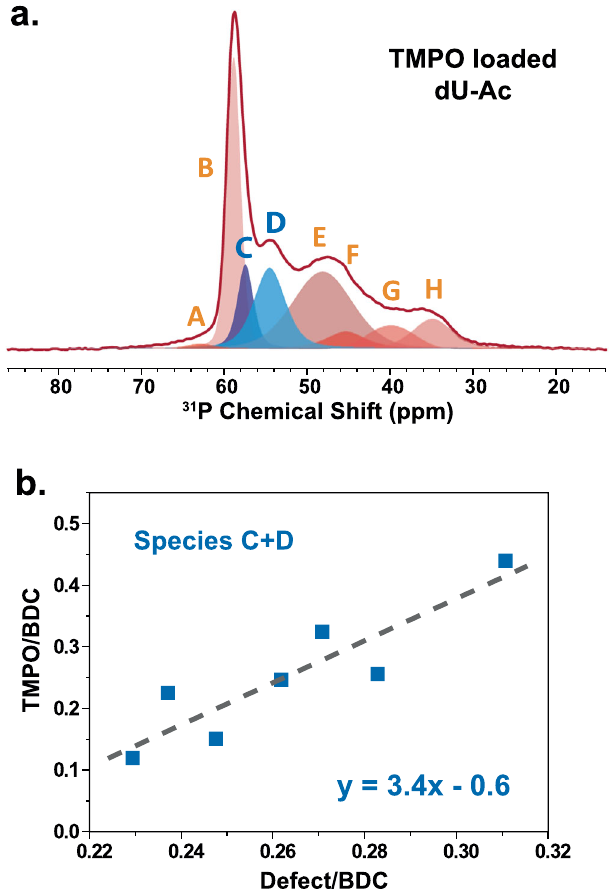
Fig. 5 | Quanti fi cation of defects. a A representative 31 P direct polarization (DP) spectrumofTMPOloadedindU-Ac.LettersA-Hcorrespondtodifferentadsorption sites shown in Fig. 3d. The blue deconvoluted peaks represent the species C and D of TMPOwhich are associatedwith defects. b The molarconcentrations of species CandD(measuredby 31 PNMR)versusthedefectconcentrationsmeasuredbyTGA. The dashed line corresponds to the fi tting curve of the linear